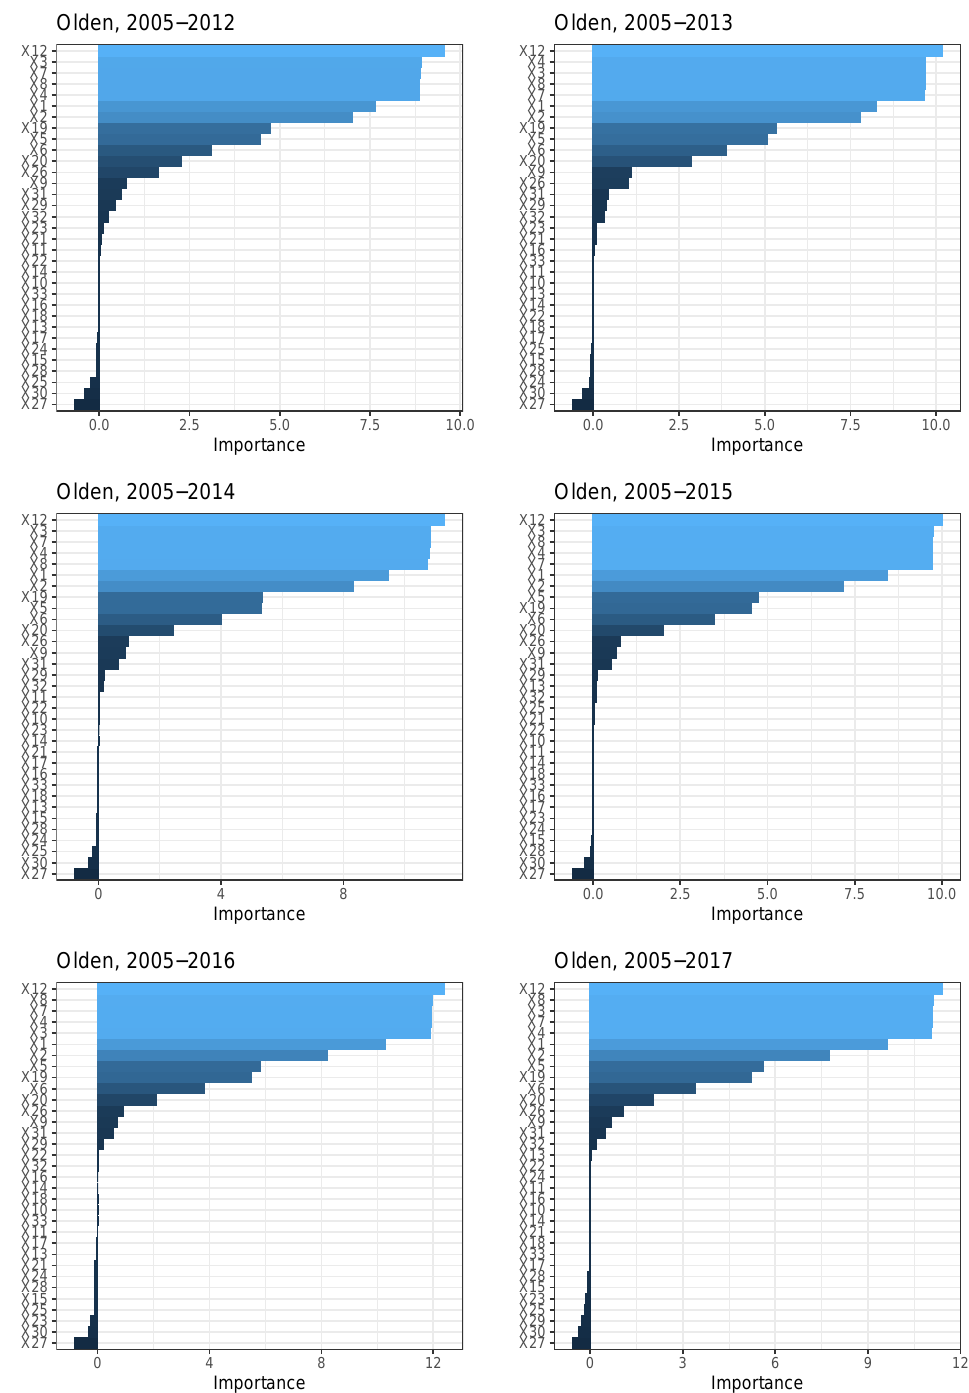
Figure 4. ANN variables’ importance across the learning phases. Note: The figure shows the importance of the input variables (from X 1 to X 30 ) for each learning phase, according to the procedure proposed by Olden et al.